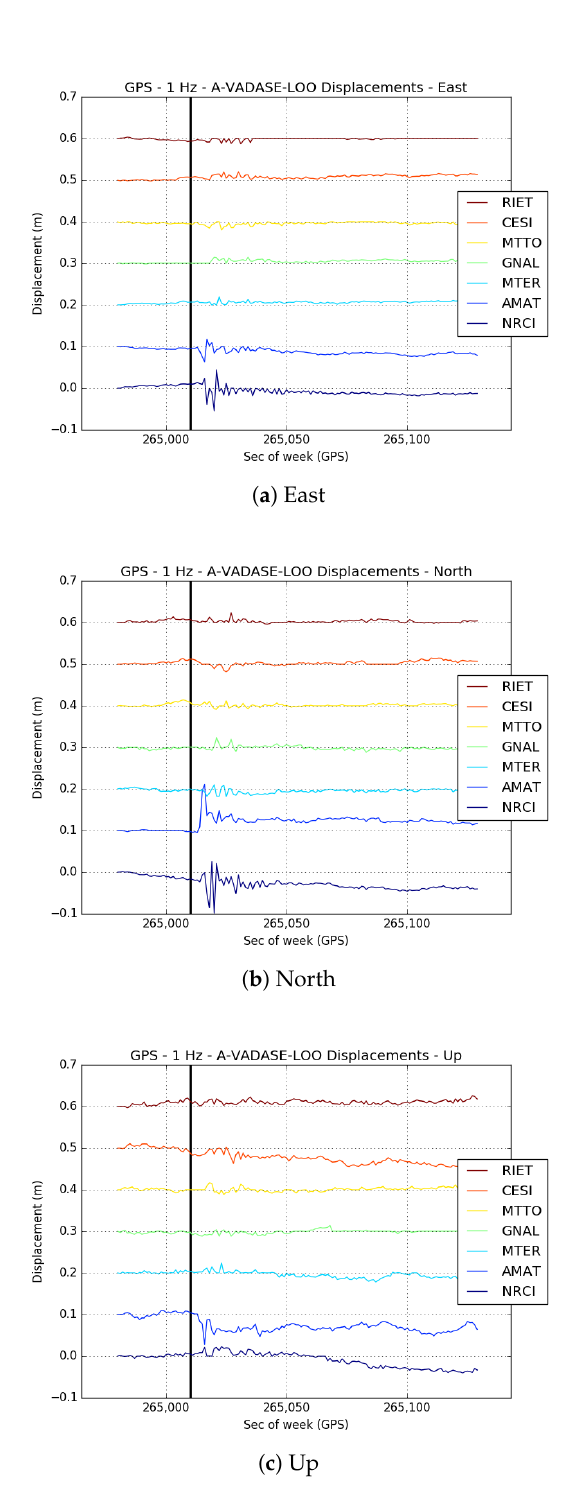
Figure 6. Estimated displacements after detrending by A-VADASE-LOO for the 150-s interval across the 24 August 2016 main shock (GPS